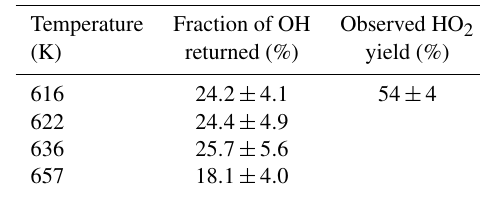
Table 3. OH recycling and HO 2 yields from experiments carried out under elevated temperatures ( > 600K); all experiments were carried out with photolysis at